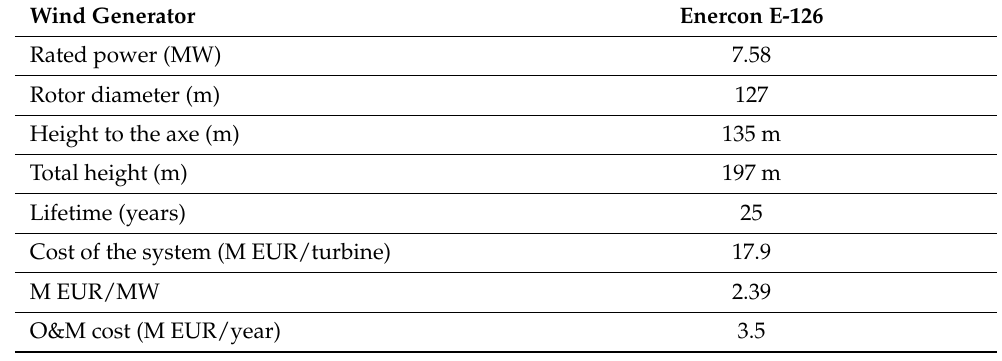
Table 4. Datasheet of the wind turbine [48].